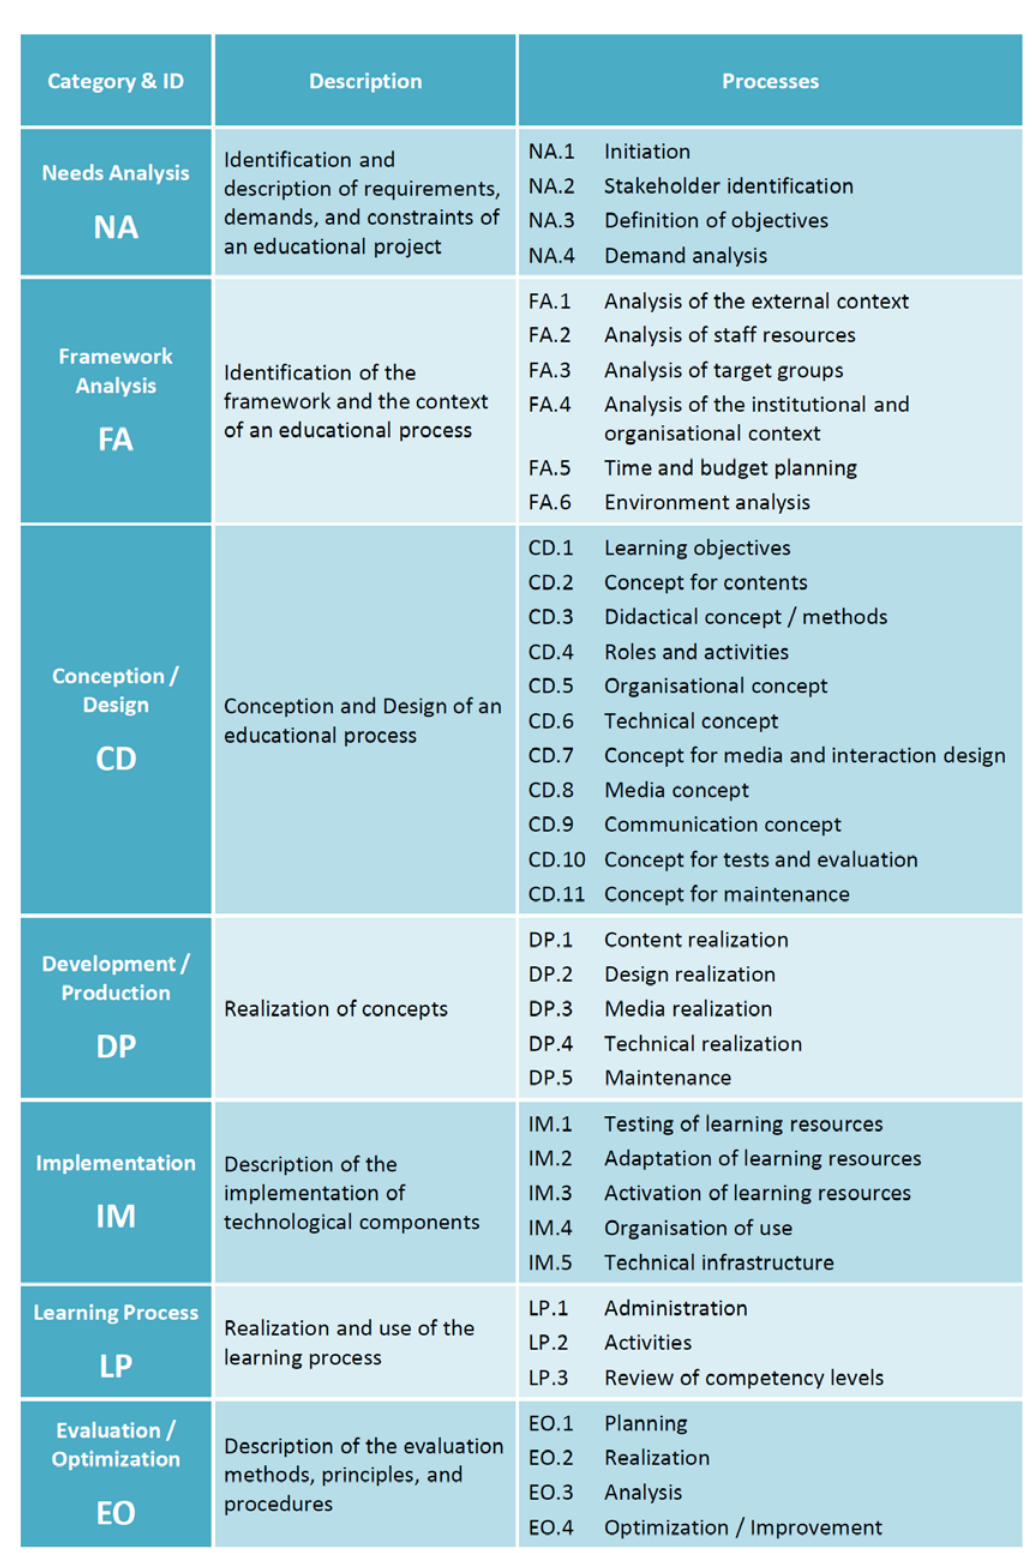
The Reference Process Model of ISO/IEC 40180 (former ISO/IEC